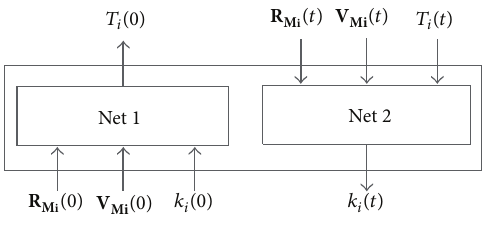
Figure 5: Expert system with two